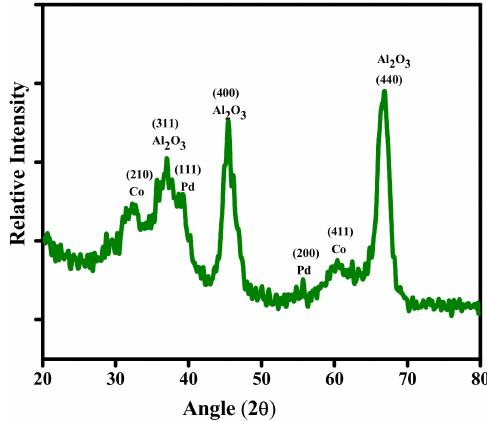
Figure 2. XRD pattern of the prepared Co–Pd@Al 2 O 3 bimetallic catalyst.